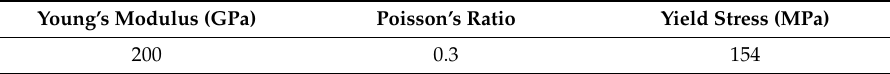
Table 3. Material properties of the blank (SPCC).